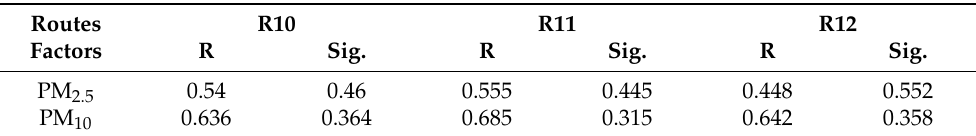
Table A3. Correlation coefficients of passenger number and PM in the metro carriage on some additional routes.